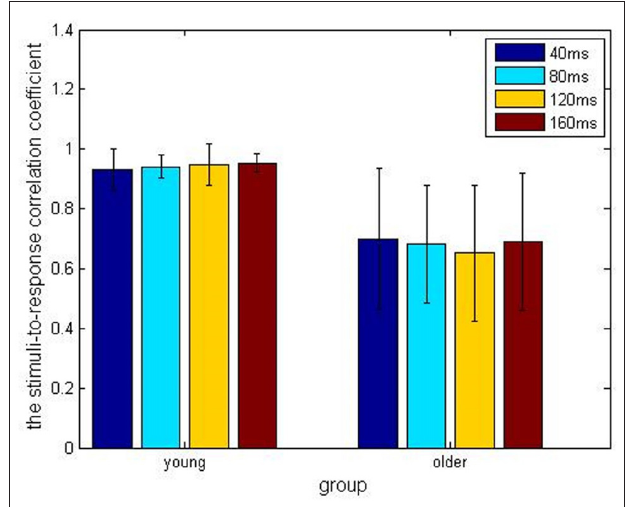
FIGURE 2 | The stimulus-to-response correlation coefficients obtained under the four different inter-stimulus intervals (ISIs) of 40 ms (blue), 80 ms (cyan), 120 ms (amber) and 160 ms (crimson), respectively, and divided into the young (left) and older (right) adult